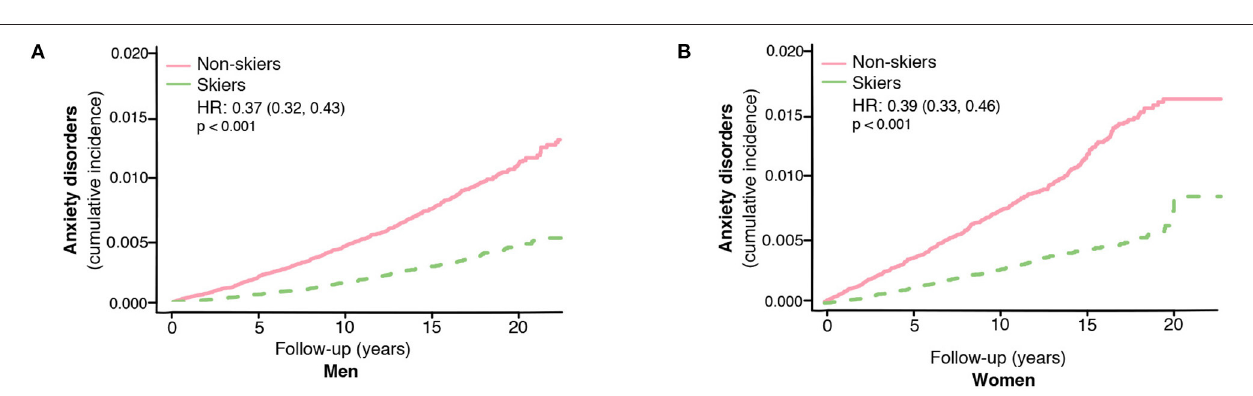
FIGURE 2 | The risk of developing anxiety disorders in skiers compared to non-skiers in men (A) and women separately (B) . HR represents hazard ratios from an unadjusted cox regression.